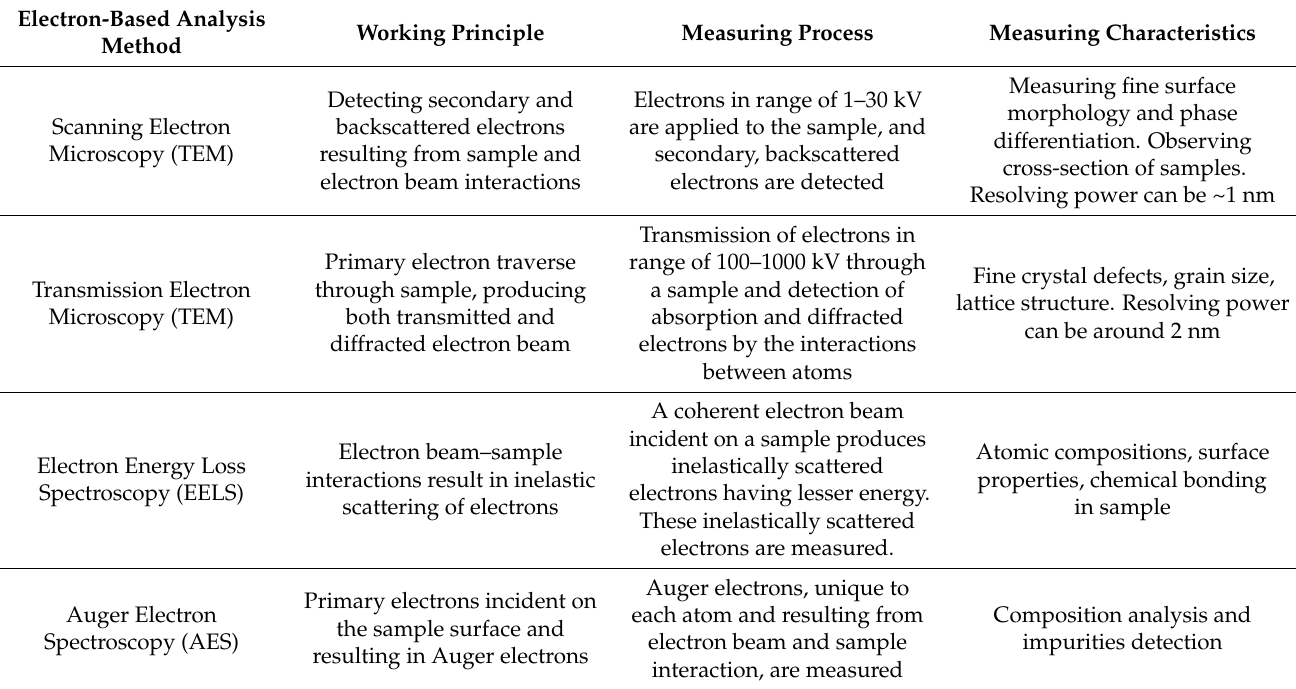
Table 5. Summary of electron-based material characterization techniques